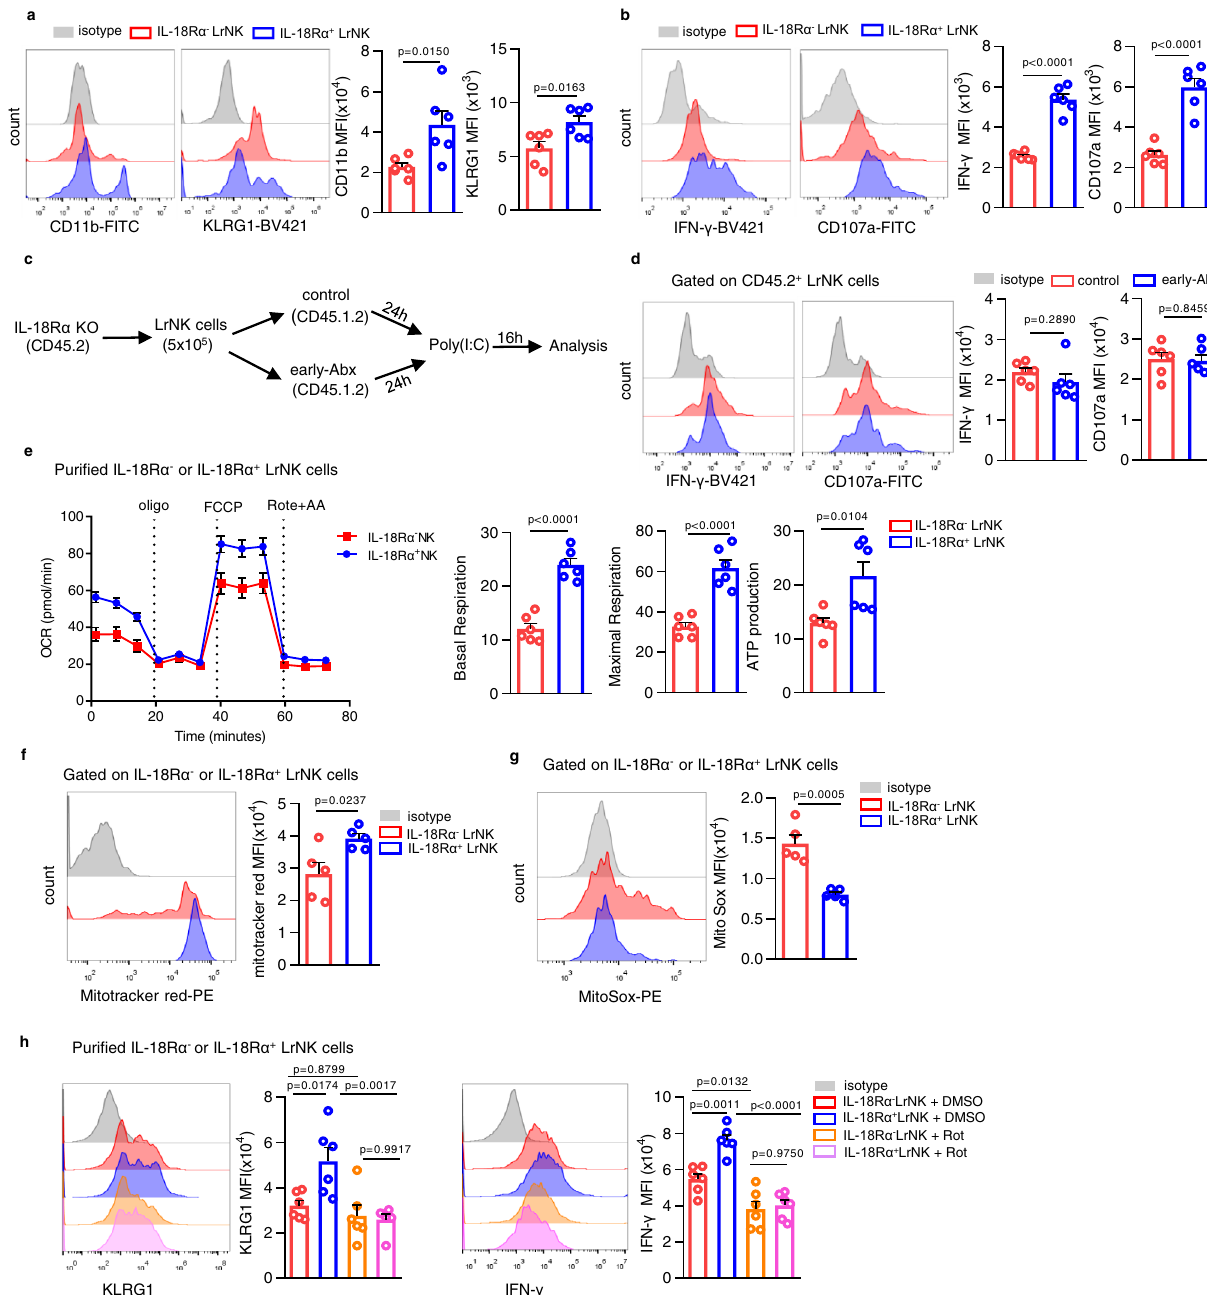
Fig. 7 | IL-18 / IL18R promotes LrNK maturation through improving mito- chondrial oxidative phosphorylation. a , b Representative FACS plots and bar graphfortheexpression(MFI)of maturationmarkers(A)oreffectormolecules(B) in IL-18R α - LrNK and IL-18R α + LrNK in C57BL/6 mice ( n =6 per group). c , d Experimental scheme and representative FACS plots and bar graph for the expression (MFI) of IFN- γ and CD107a in IL-18R α -de fi cient LrNK cells (CD45.2) transferred into control or early-Abx mice (CD45.1) mice ( n =6 per group). e Representativeimagesforoxygenconsumptionrate(OCR)analysisofpuri fi edIL- 18R α + andIL-18R α - LrNKcellsstimulatedwithIL-15exvivoandthebasalrespiration, maximum respiration and ATP production were analyzed ( n =6 per group).